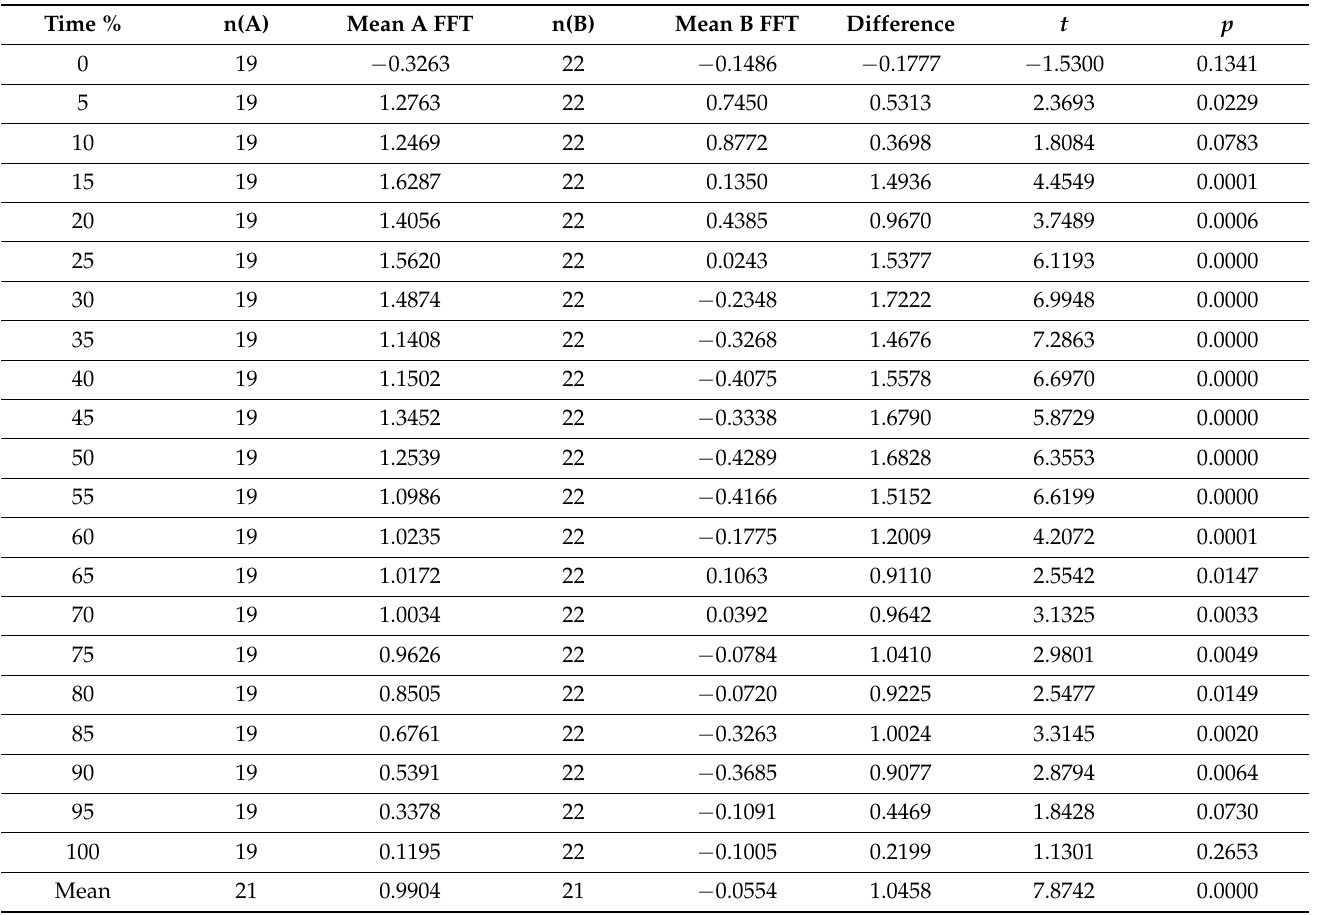
Table 4. Comparison of the sagittal linear acceleration of the head with Student’s t -tests for indepen- dent variables for FFT between groups A and